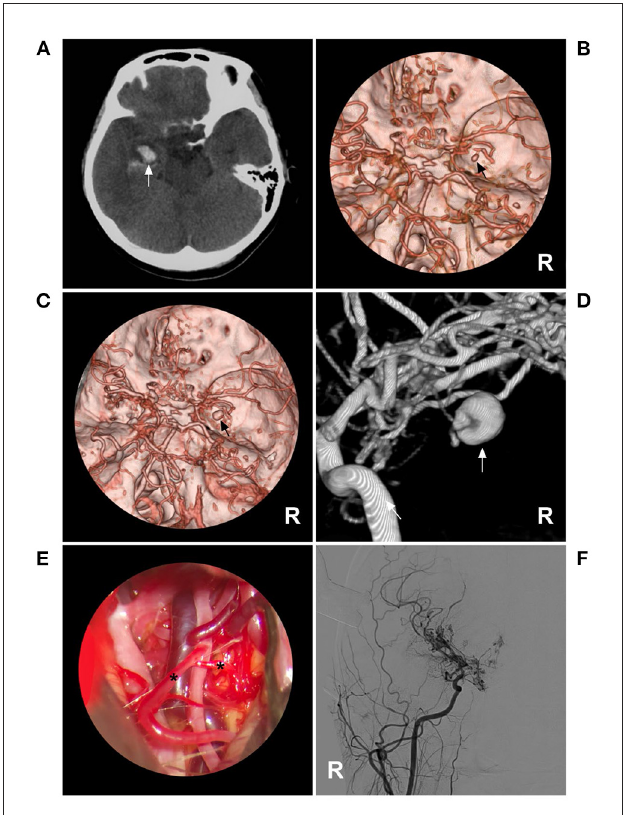
FIGURE6 A growing aneurysm in case 2 in Table 2. (A) CT showed hemorrhage (arrow) in the right temporal lobe involving the ventricle. (B) CTA showed an aneurysm (arrow) in the right moyamoya vessels, and bilateral MMD can be seen. (C) One week later, repeated CTA showed that the aneurysm had grown (arrow). (D) Three-dimensional DSA of the right ICA showed that the aneurysm (arrow) vessels affected by MMD were enlarged. (E) Intraoperative image showing the vessels affected by MMD (asterisks); these vessels appeared thin and frail. (F) Postoperative DSA after aneurysm resection showed that the aneurysm had disappeared. CT, computed tomography; CTA, computed tomography angiography; DSA, digital subtracted angiography; ICA, internal carotid artery; MMD, moyamoya disease; R, right.